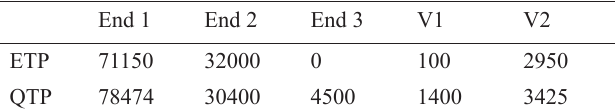
Table 2. Total volume (meters) performed during endurance training period (ETP), and quality training period